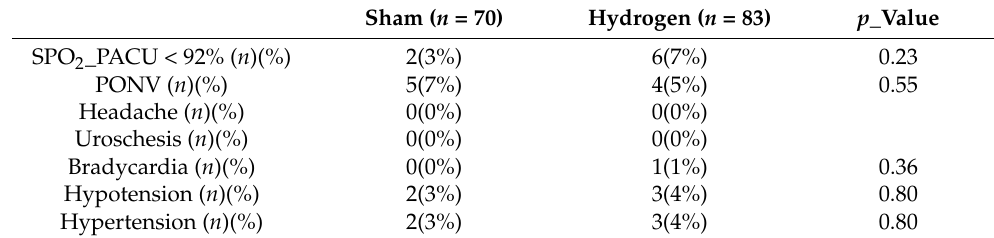
Table 4. Postoperative adverse effect